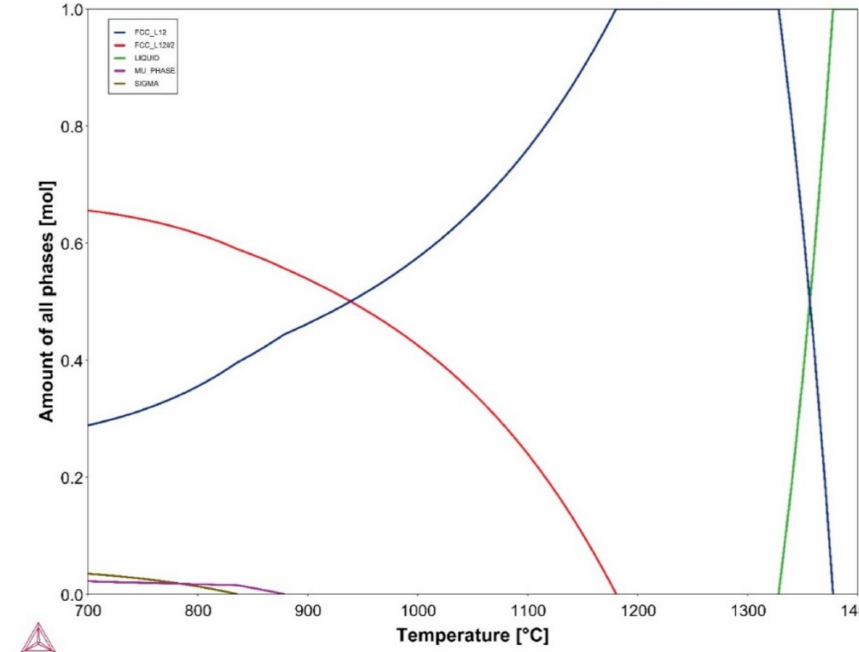
Figure A1. The thermodynamic equilibrium step diagram of MAD542 using the TCNI10 database in the Thermo-Calc